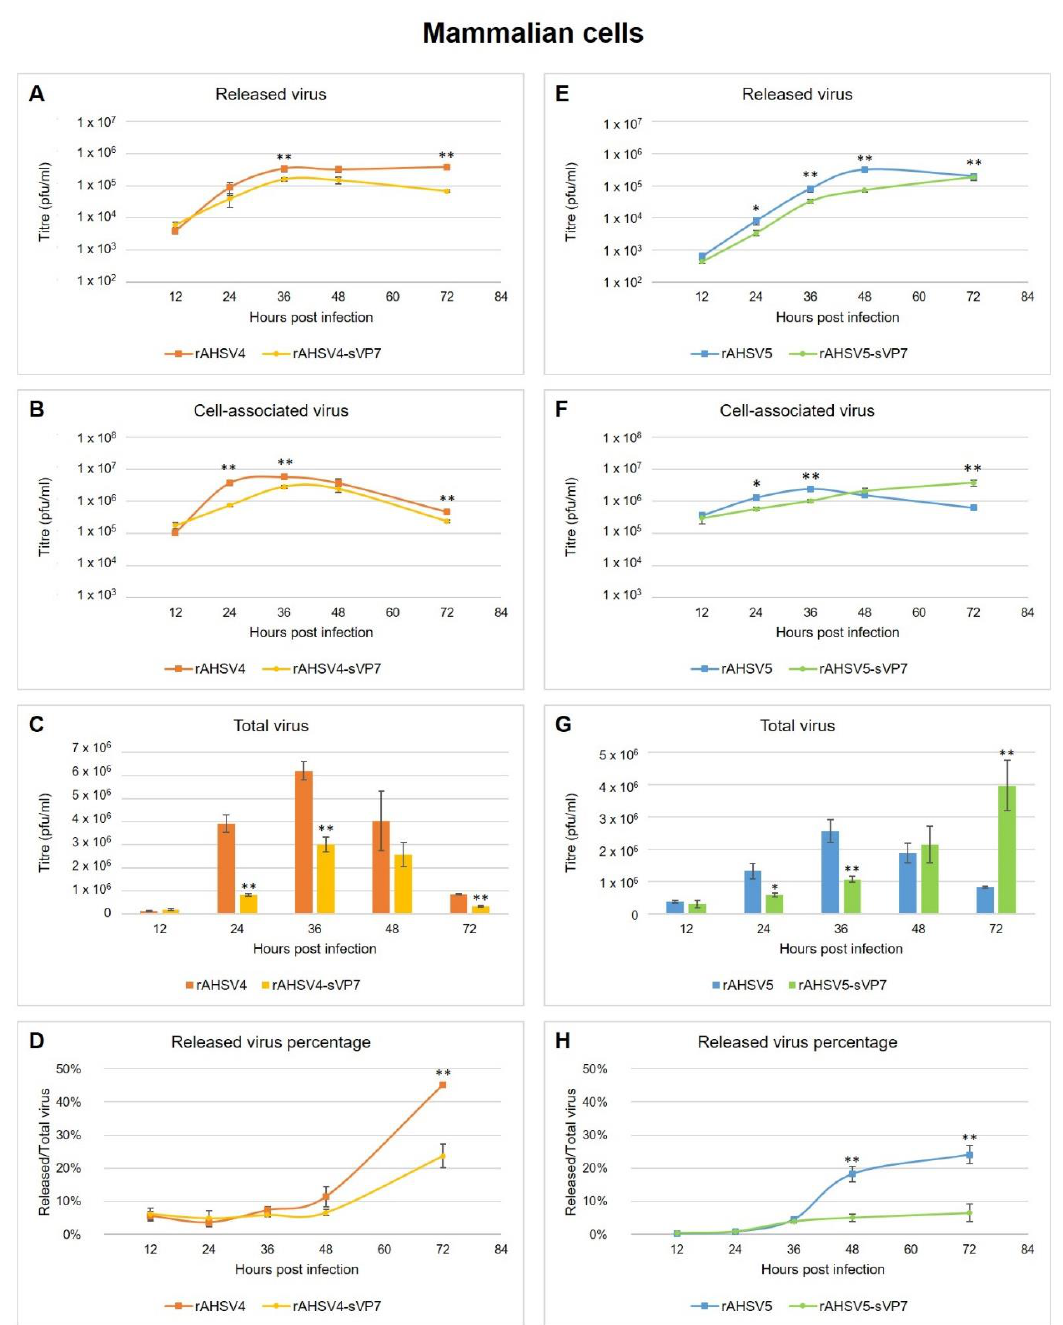
Figure 5. Replication kinetics of rAHSV and rAHSV-sVP7 recombinant viruses for attenuated serotype 4 ( left ) and virulent serotype 5 ( right ) in mammalian cells. ( A , E ) Released virus fraction from infected cells (mean titre of virus collected from media) represented on a logarithmic scale. ( B , F ) Cell-associated virus fraction from infected cells (mean titre of virus collected from lysed cell monolayers) represented on a logarithmic scale. ( C , G ) Total virus yield (sum of released and cell- associated virus fraction titres) represented on a linear scale to show proportional differences between each virus at each time point. ( D , H ) Percentage virus released (mean titre of released virus/mean titre of total virus*100). Equal amounts of BSR cells were infected at a MOI of 0.1 of each virus, in triplicate, and incubated for 12, 24, 36, 48 and 72 h. Media and cells were collected separately for titration as described in Section 2.7. Standard error of the mean is indicated and statistically significant differences to the wild-type virus is indicated as * ( p ≤ 0.05) or ** ( p ≤ 0.01).